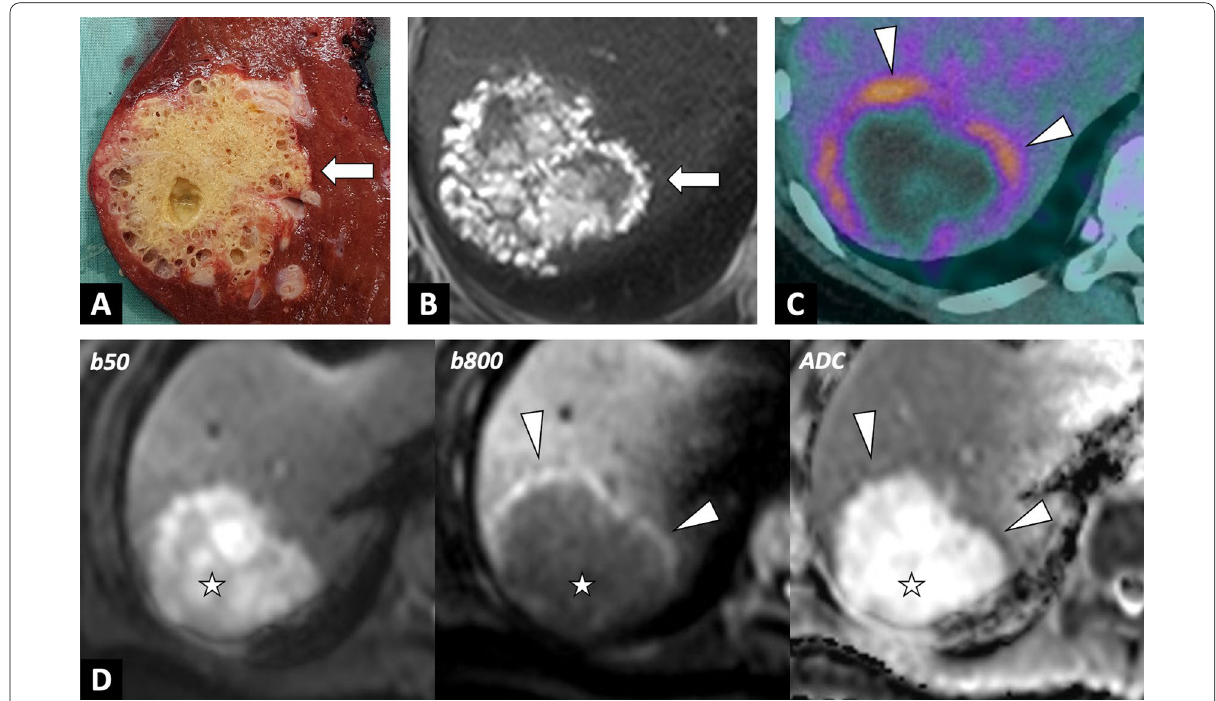
Fig. 5 Overall correlations of right liver alveolar echinococcosis in a 54‑year‑old women. A Photograph of gross specimen after right hepatectomy showing multiples microcysts with honeycomb aspect. B T2‑weighted MR image in the axial plane showing typical microcysts in correlation with gross specimen (arrows; Kodama 2). C FDG‑PET/CT scan showing active parasitic lesion with increased FDG‑uptake at the periphery of the lesion. D Correlation with diffusion‑weighted imaging showing peripheral hypersignal of AE lesion with low ADC